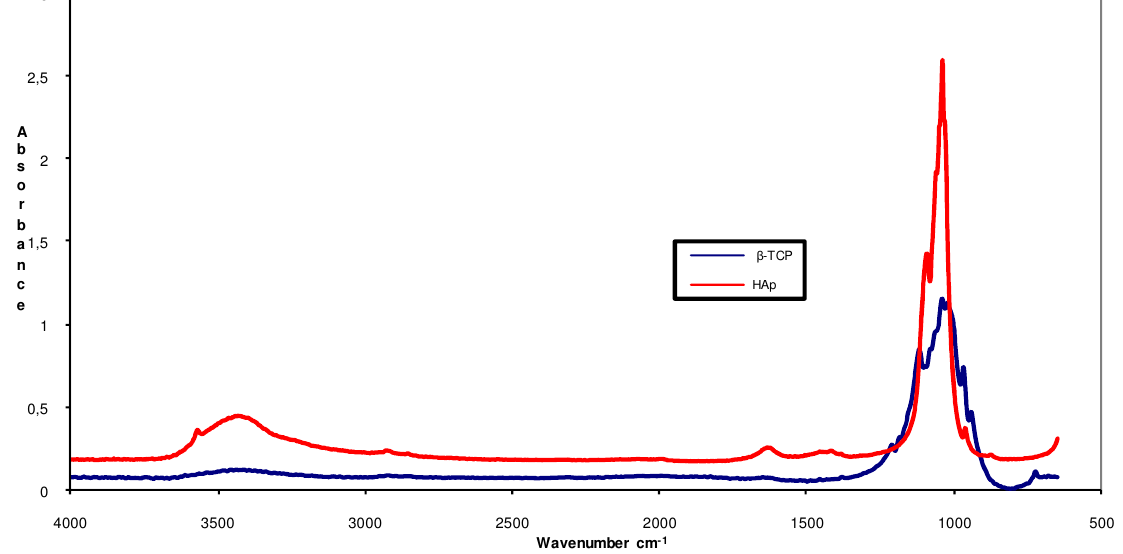
Figure 3. FTIR spectrum of the commercial HAp and β